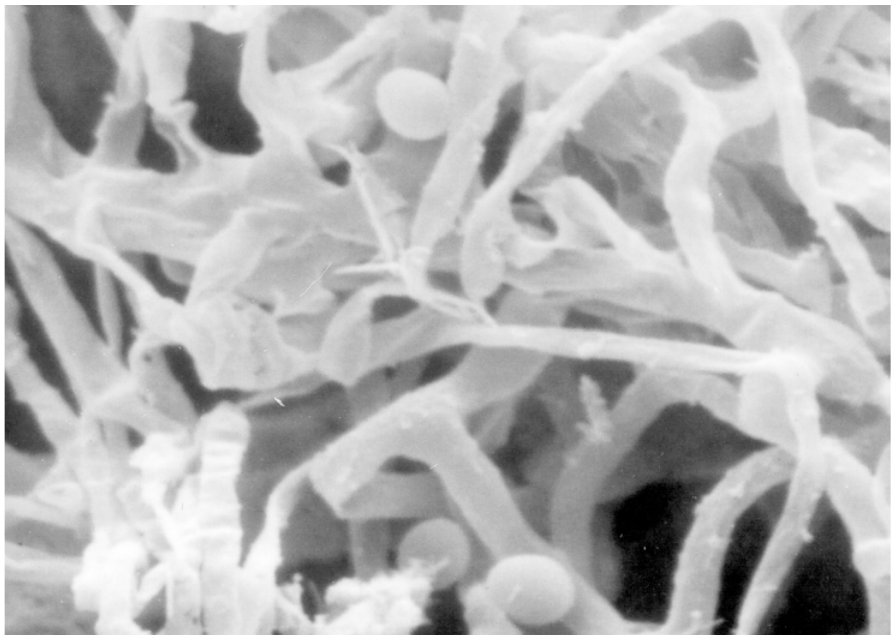
Fig. 2. Conidia of Phoma capitulum (SEM x 5100). Phot. M.